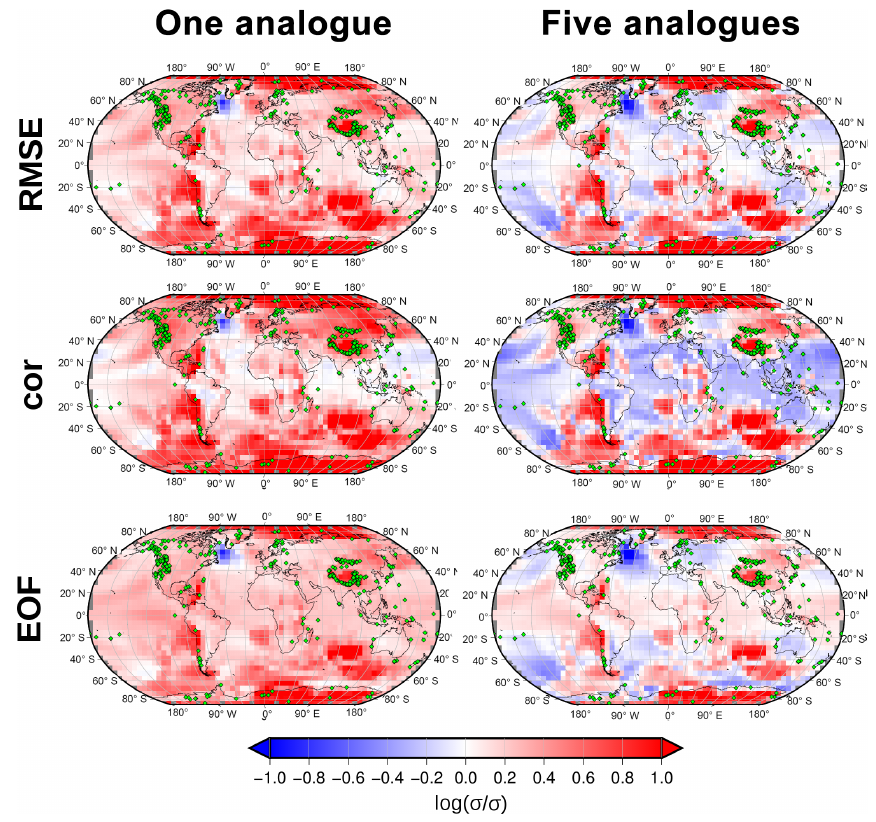
Figure 3. As in Fig. 2, but for the logarithm of the ratio of the standard deviation of the reconstruction and the original simulation. Red (blue) shading depicts areas where the reconstruction overestimates (underestimates) variability.